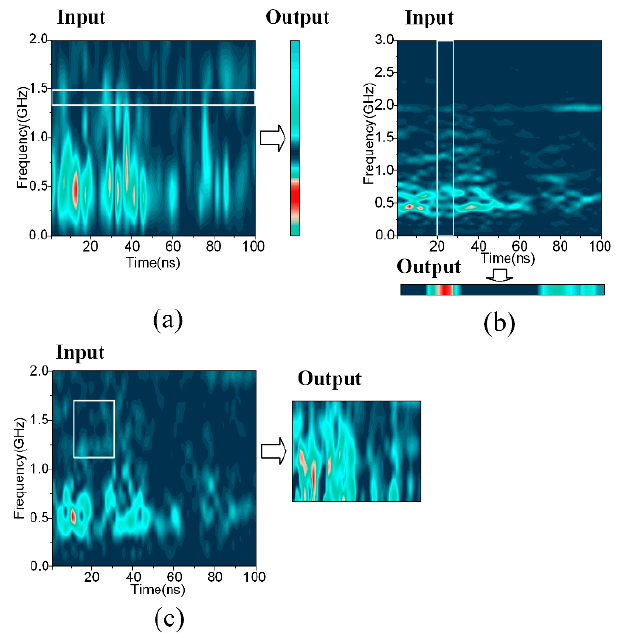
Figure 16. The outputs of the first layer of convolutional filters. ( a ) The output of the temporal filter; ( b ) the output of the frequency filter; ( c ) the output of the texture filter.